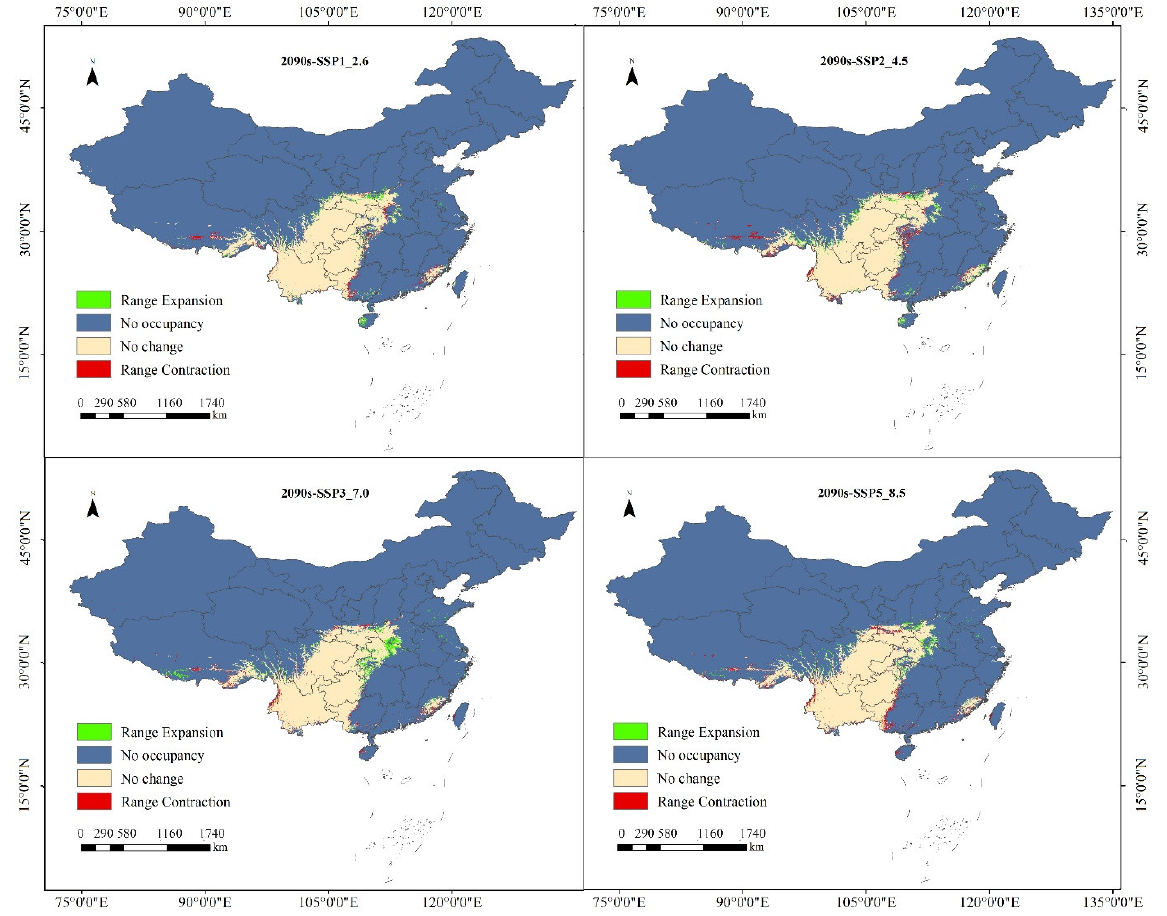
Figure 6. Changes in the suitable habitats of S. delavayi under four climate scenarios in the 2090s.